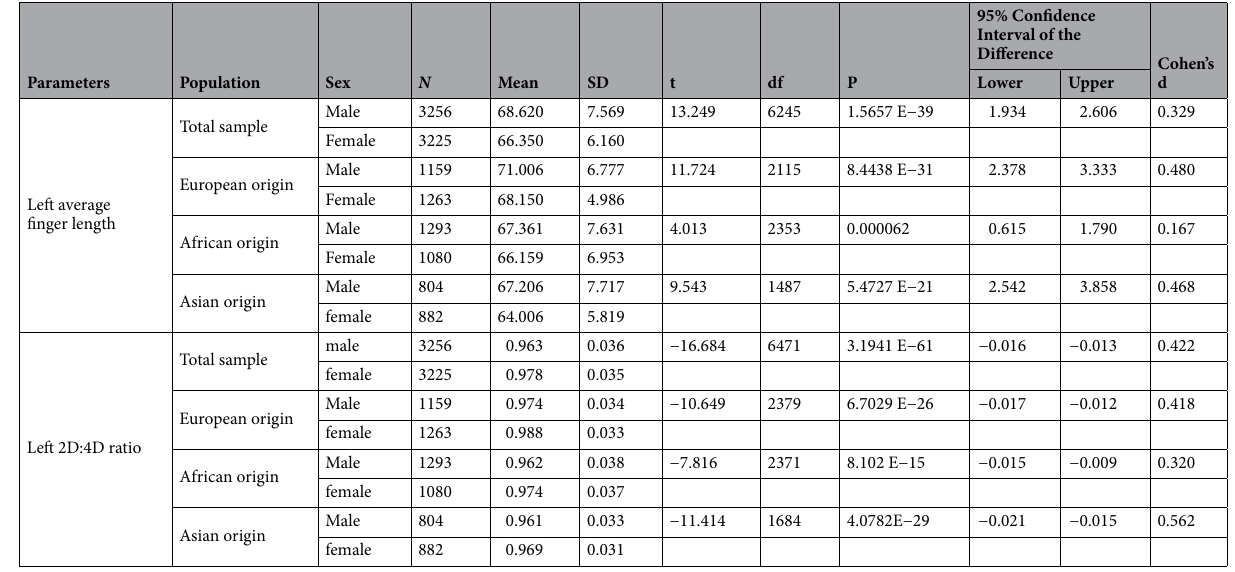
Table 1. Sex differences in finger measurements and 2D:4D ratios for both hands in total sample and European, African and Asian populations. Sex differences presented according to Student’s T test ( t test statistics, SD std. deviation, df degrees of freedom, p statistical